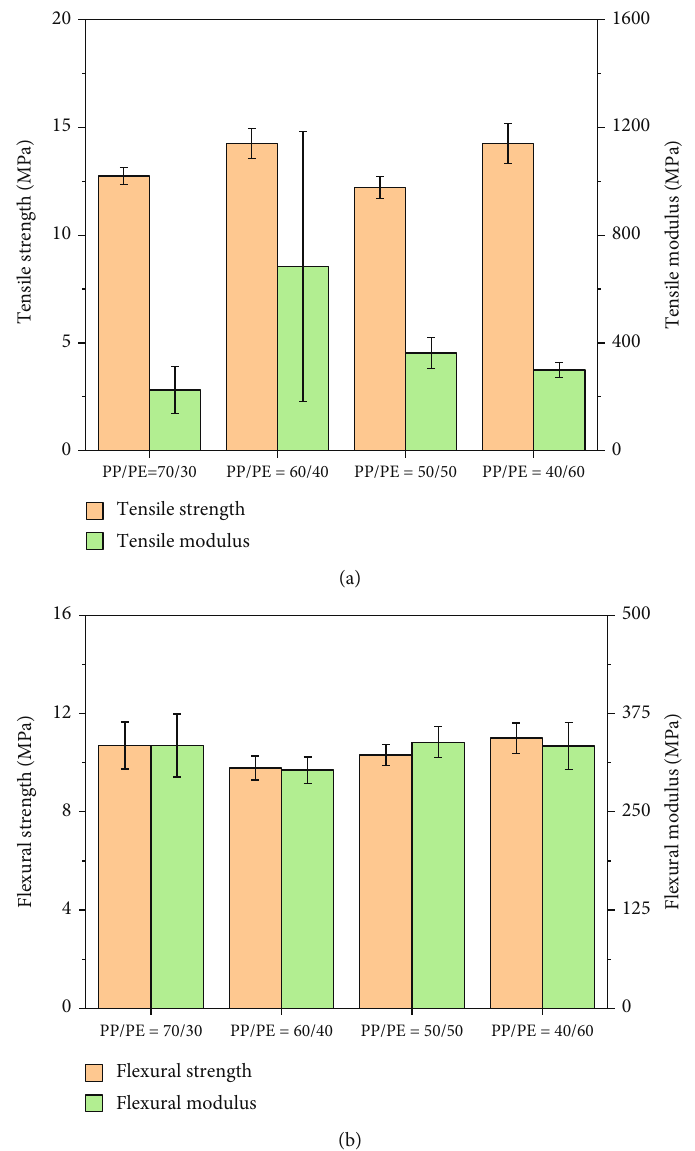
Figure 4: (a) The tensile strength and tensile modulus and (b) the fl exural strength and fl exural modulus of SUPAs with di ff erent content ratios of